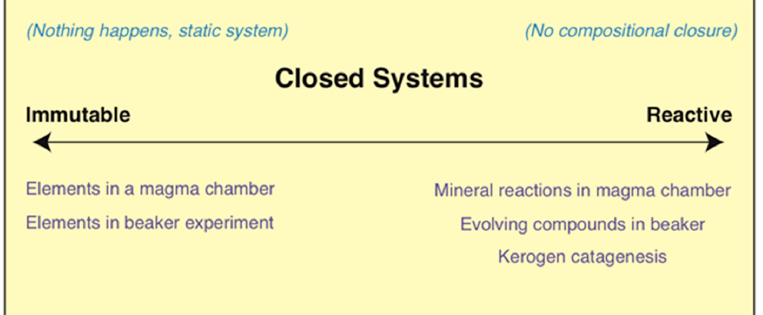
Figure 1. Compositional closure status in closed systems with immutable and with reactive compo- nents and examples thereof.